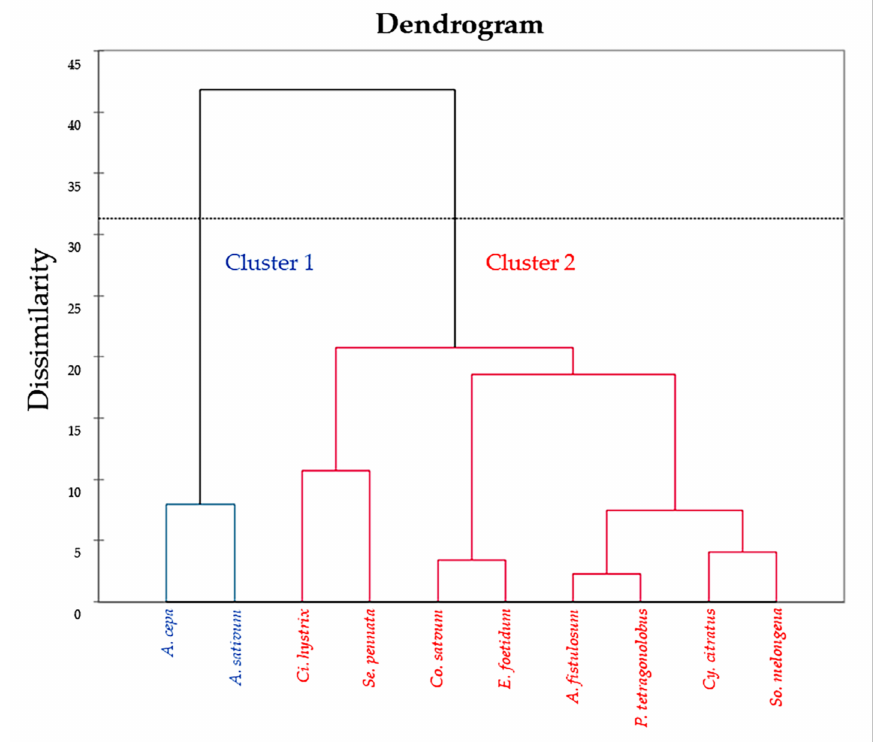
Figure 2. The dendrogram of hierarchical cluster analysis (HCA) of ten vegetable